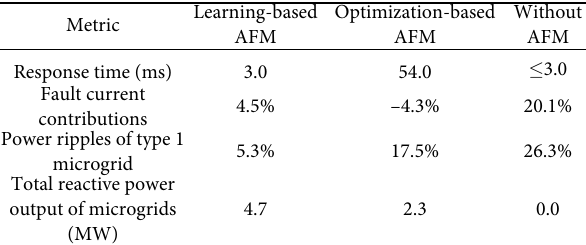
Fig. 11 Results for single-phase-to-ground faults without AFM. ( a ) phase currents at the fault location. , , and are total fault currents to the ground, fault currents from the main grid, and fault currents from microgrids, respectively. ( b ) The magnitude difference between , and , i.e., , which are also fault current contributions from microgrids. ( c ) The power output of microgrid 2. Table 1 Comparison of different control methods during